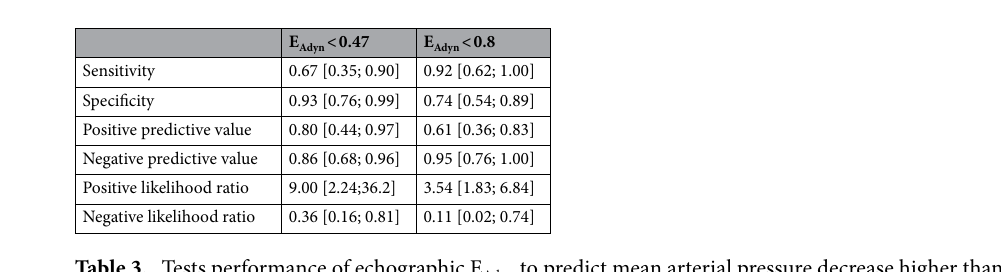
Table 3. Tests performance of echographic E Adyn to predict mean arterial pressure decrease higher than 10% after norepinephrine decrease for various threshold.